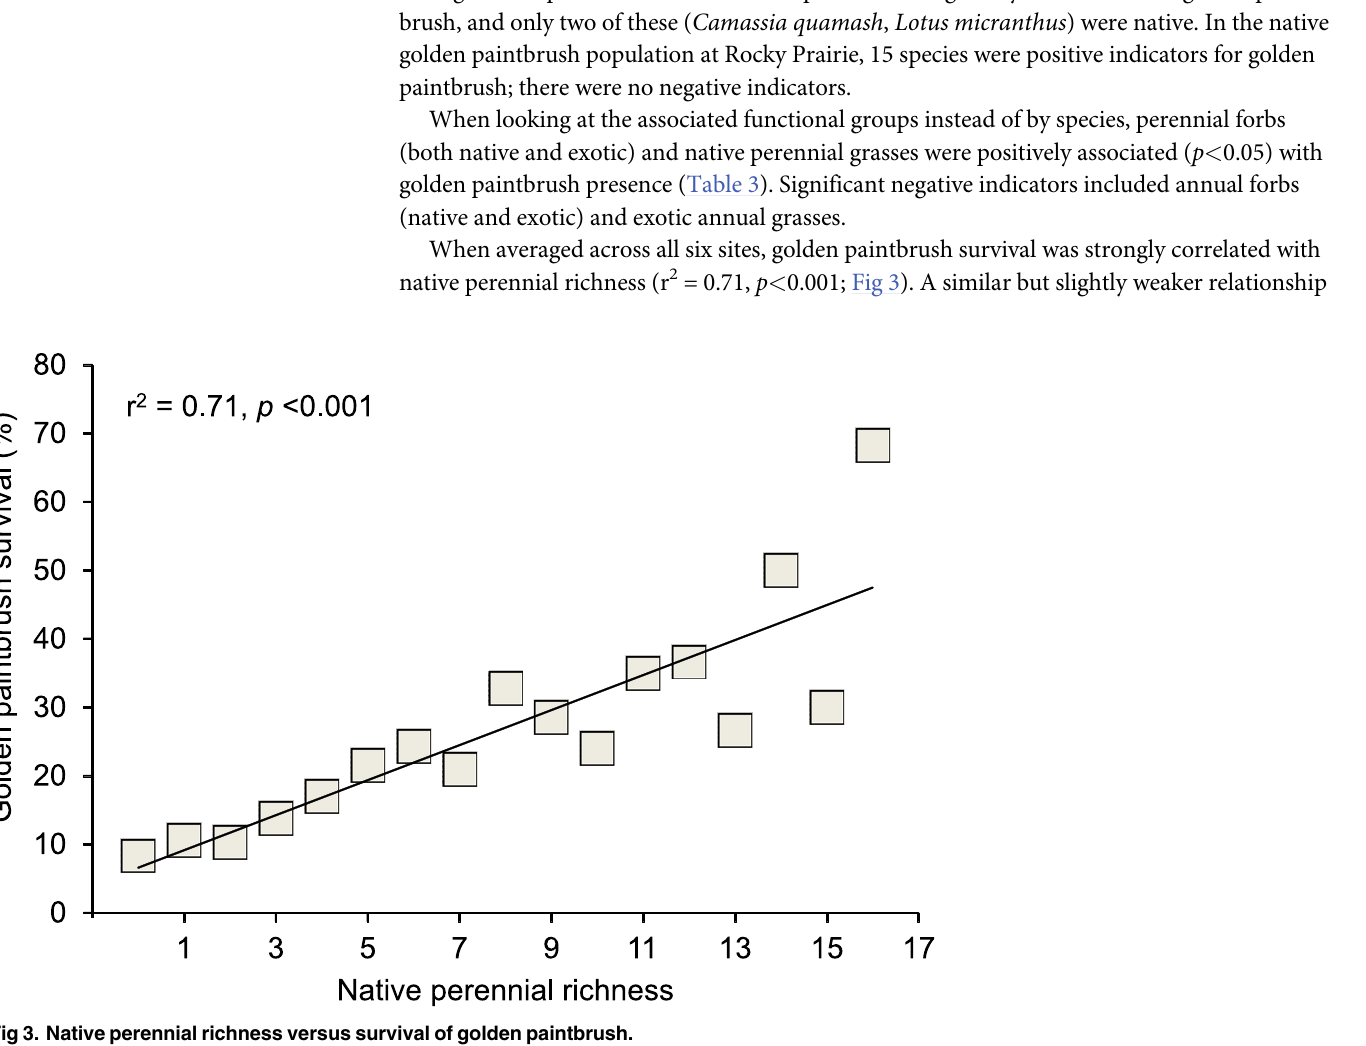
but significant positive indicators. Nine species were negatively associated with golden paint- brush, and only two of these ( Camassia quamash , Lotus micranthus ) were native. In the native golden paintbrush population at Rocky Prairie, 15 species were positive indicators for golden paintbrush; there were no negative indicators.